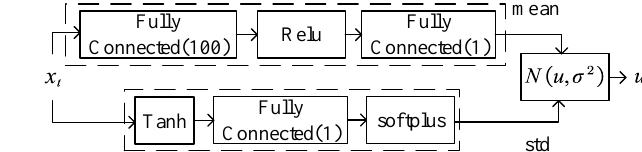
Figure 10. Actor